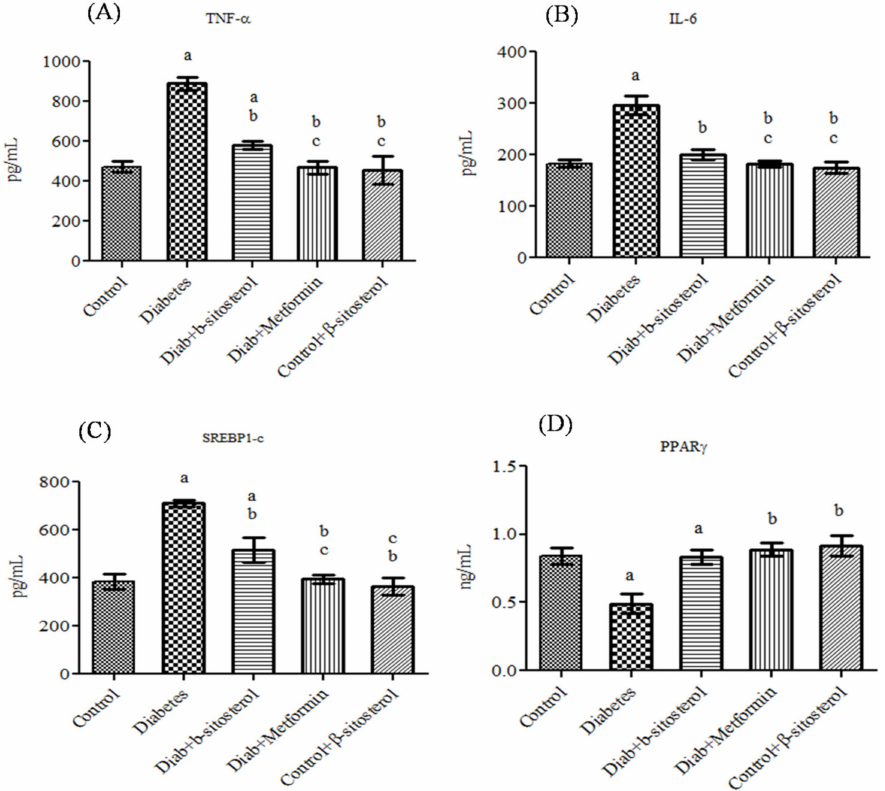
Figure 2. Effect of SIT on serum tumor necrosis factor- α (TNF- α ), interleukin-6 (IL-6), sterol regulatory element binding protein-1c (SREBP-1c) and peroxisome proliferator-activated receptor- γ (PPAR γ ) concentration in type-2 diabetic rats. The serum levels of these proteins were assessed by the Enzyme Linked Immuno Sorbent Assay (ELISA) method. Significance at p < 0.05, a significantly different from the control group. b Significantly different from the diabetic control and c significantly different from the β -sitosterol treated diabetic